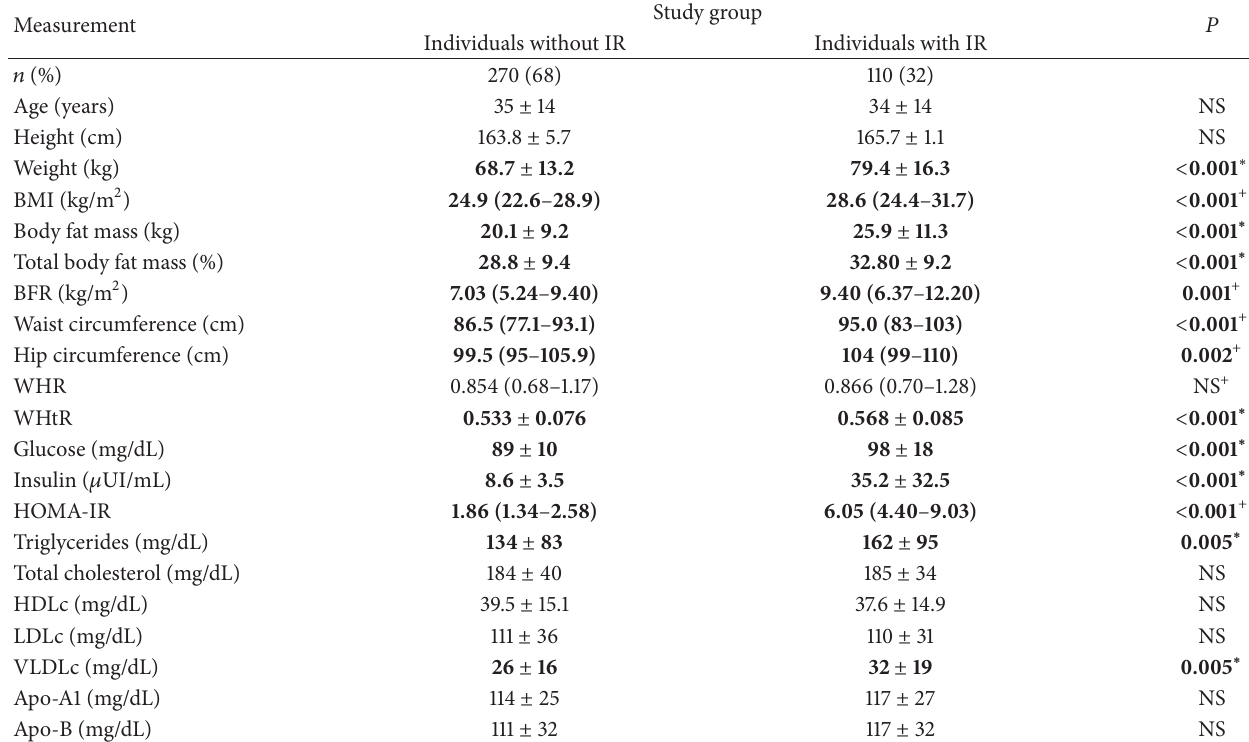
Table 1: Anthropometric characteristics and metabolic markers in individuals included in the study. Study group 𝑃 Measurement Individuals without IR